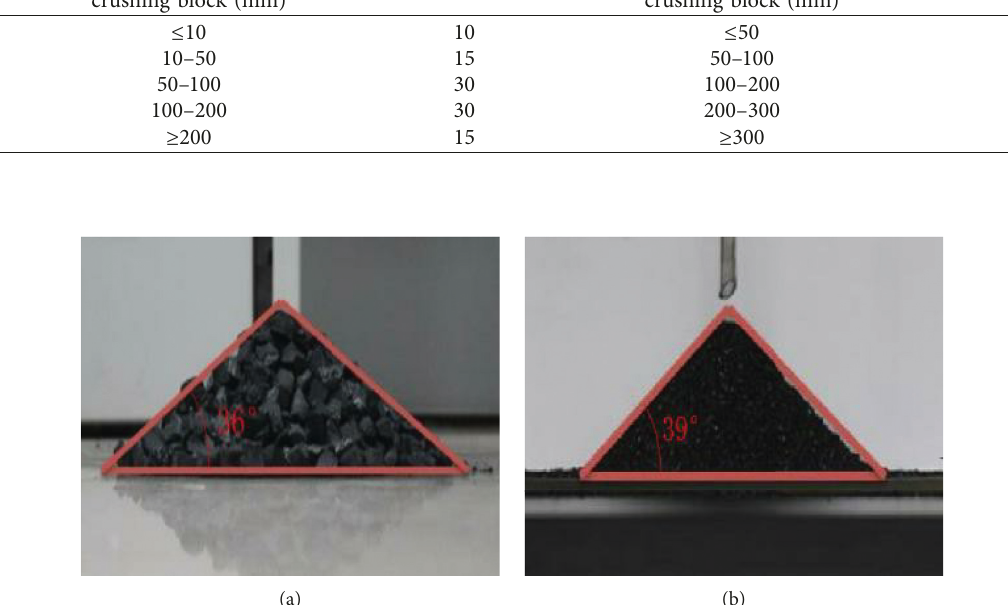
Figure 2: Natural repose angle of coal. (a) Coal with a particle size of 20mm. (b) Coal with a particle size of 2mm.